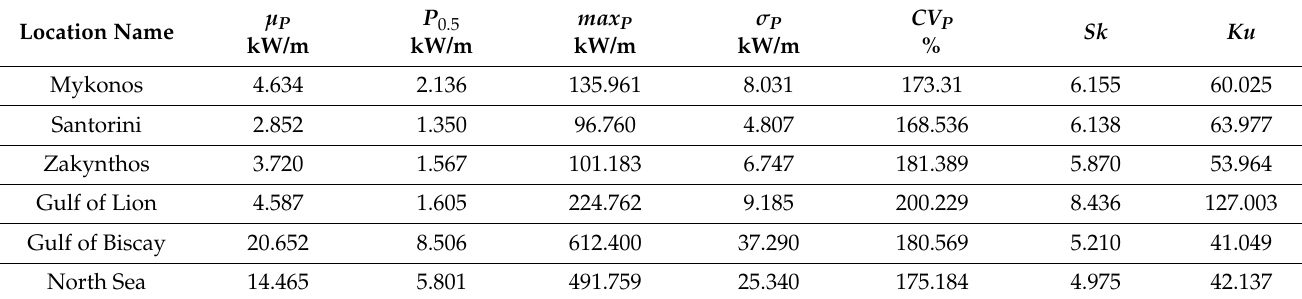
Table 2. Basic linear statistics of wave energy flux at the examined locations.